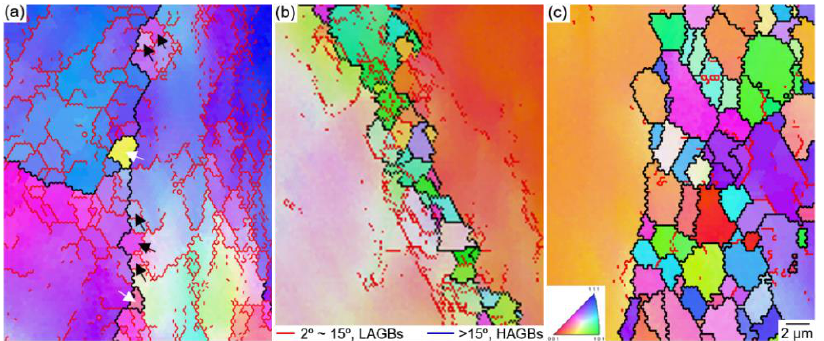
Figure 10. Magnified EBSD IPF maps shows the Co 35 Cr 25 Mn 15 Ni 15 Fe 10 TRIP-HEA hot-compressed at 1123 K with strain rates of ( a ) 0.1 s −1 , ( b ) 0.01 s −1 , and ( c ) 0.001 s −1 . at 1123 K with strain rates of ( a ) 0.1 s − 1 , ( b ) 0.01 s − 1 , and ( c ) 0.001 s − 1